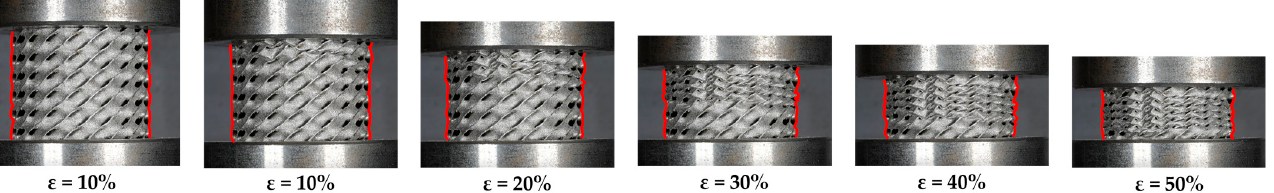
Figure 10. “Layer-by-layer” deformation mode at levels of strain 0%, 20%, 30%, 40%, and 50% for bending-dominated structure on the example of Diamond_9_1.5_0.51.